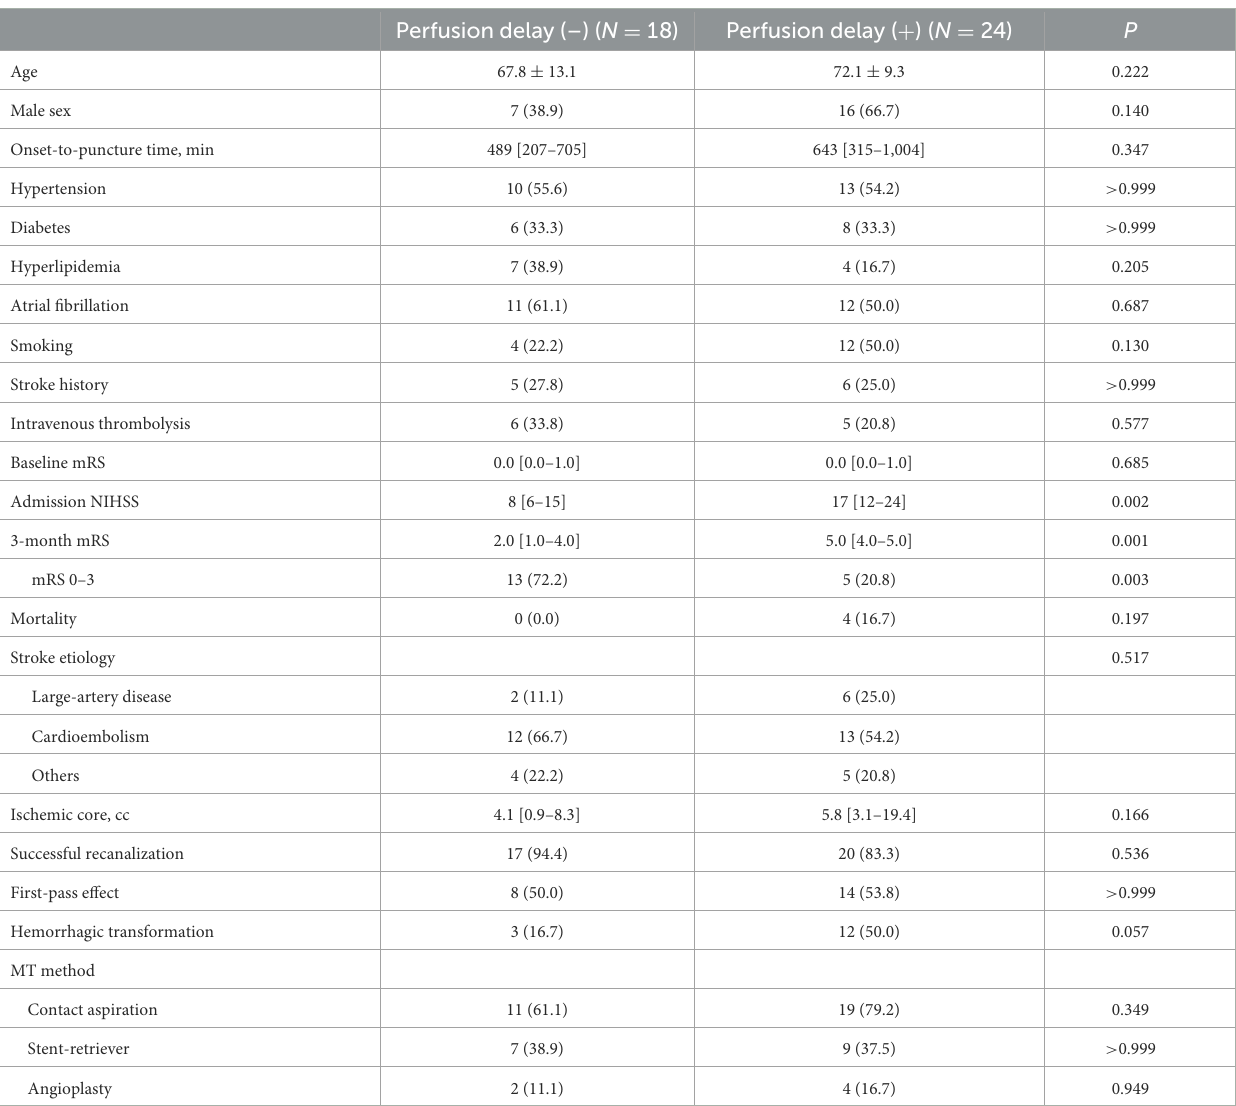
TABLE 1 Characteristics according to the perfusion delay in the low